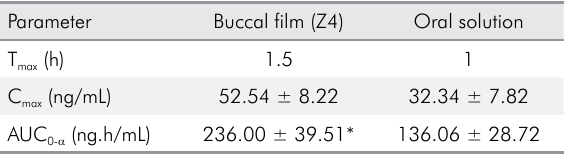
Table 3. Mean pharmacokinetic parameters of zolpidem in plasma following buccal application of film Z4 and oral solution in rabbits (mean ± SD, n =